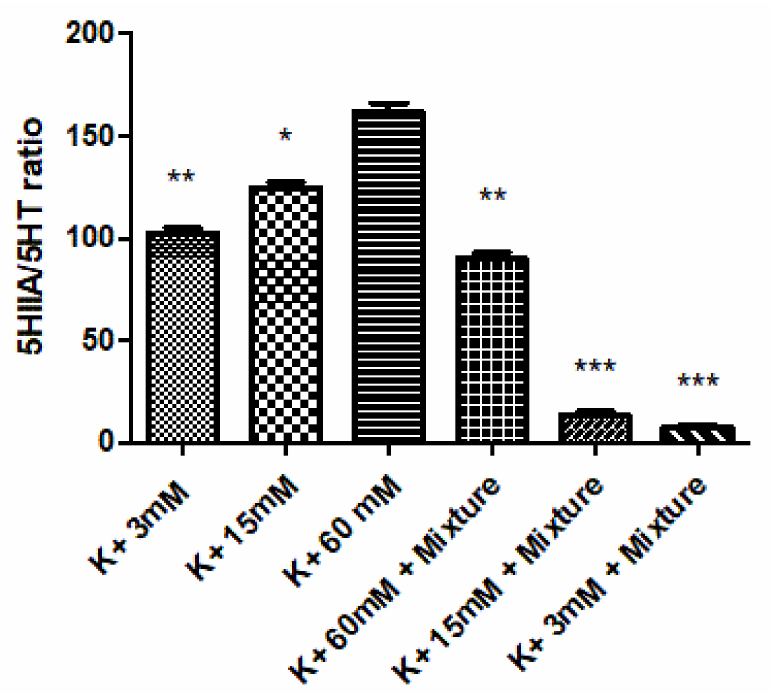
Figure 9. Inhibitory effect induced by the mixture (200 µ g/mL) on serotonin degradation (5HIIA/5- HT), in isolated mouse cortex specimens. ANOVA p < 0.0001, *** p < 0.001, ** p < 0.01, * p < 0.05 vs. K + 60 mM.